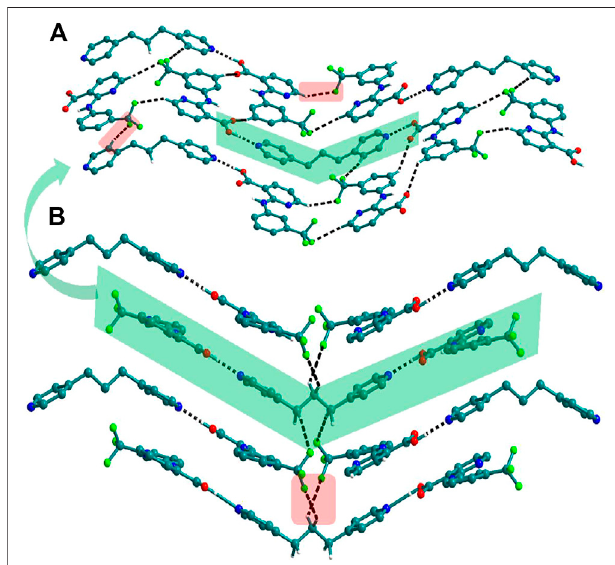
FIGURE 3 | (A) In 3 , Nif ─ bpp ─ Nif trimers are connected with other trimers forming a planar sheet via C ─ H ··· F interaction. (B) Different sheets further connect via other C ─ H ··· F interactions to form a 3D structure.